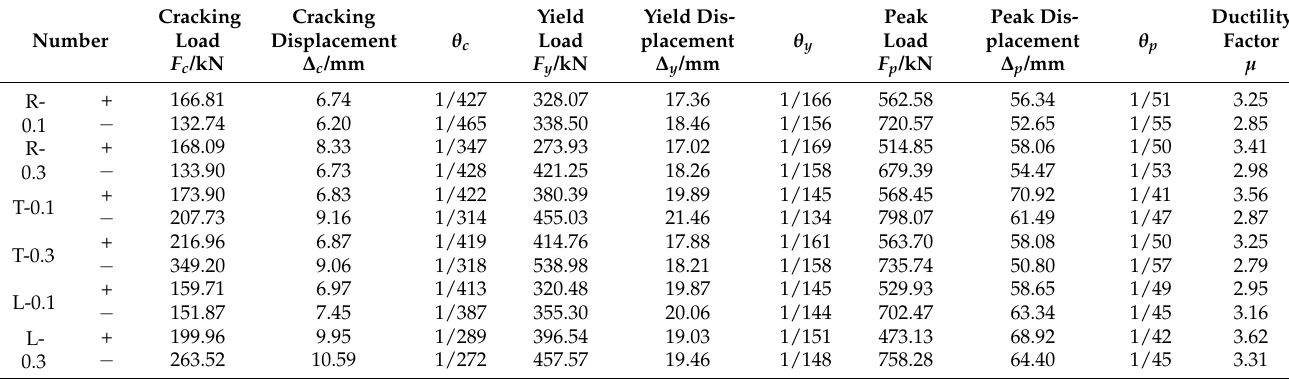
Table 6. Bearing capacity, displacement, and ductility coefficient of specimens.